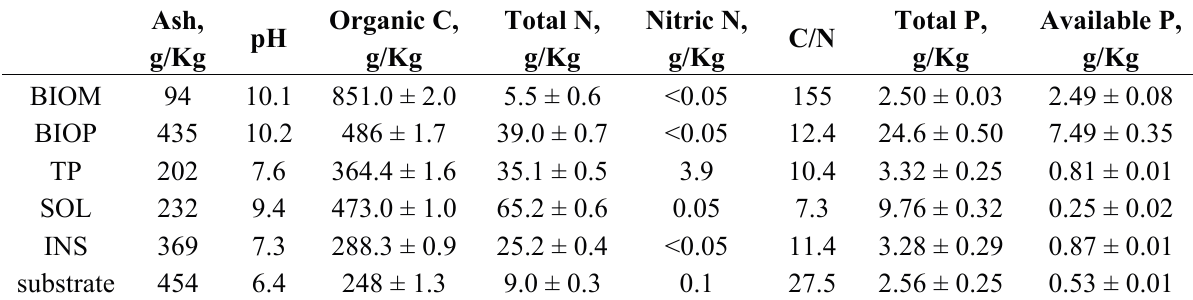
Table 1. Chemical composition of the investigated